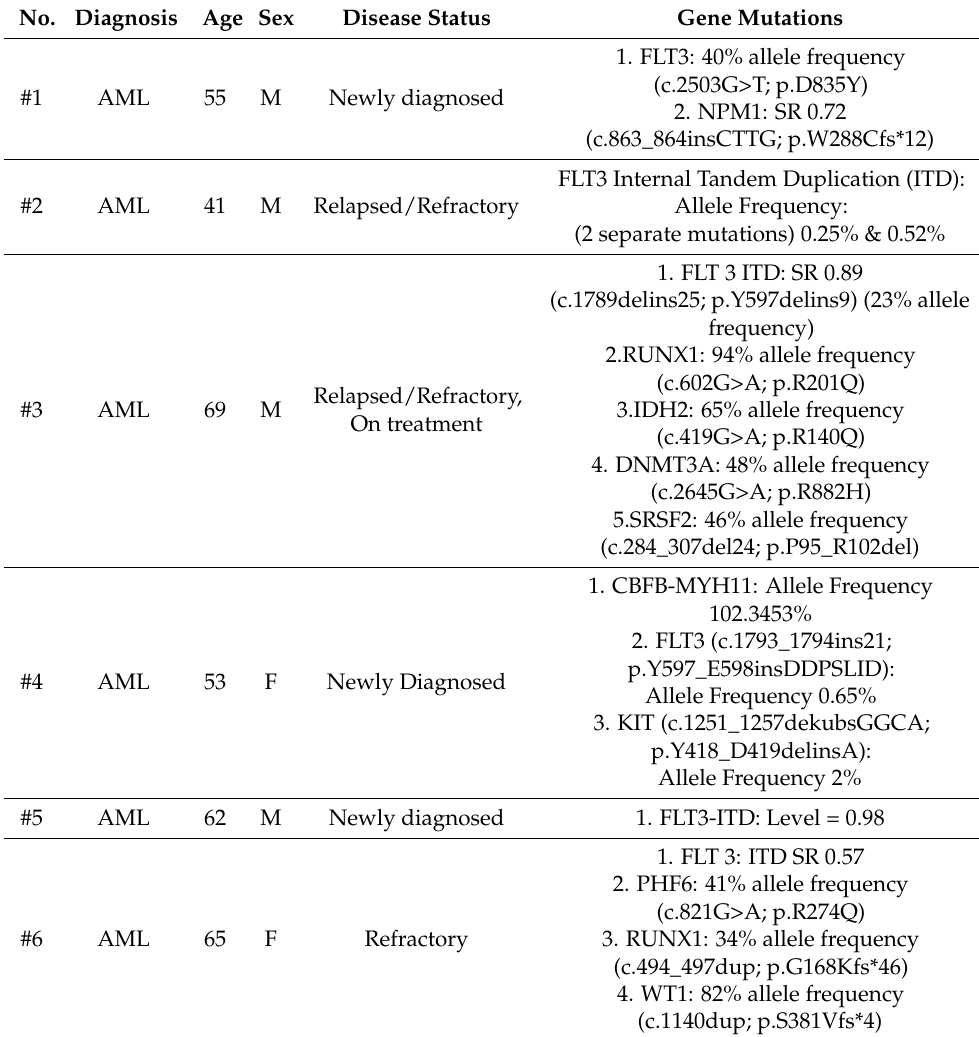
Table 1. Information of AML-FLT3